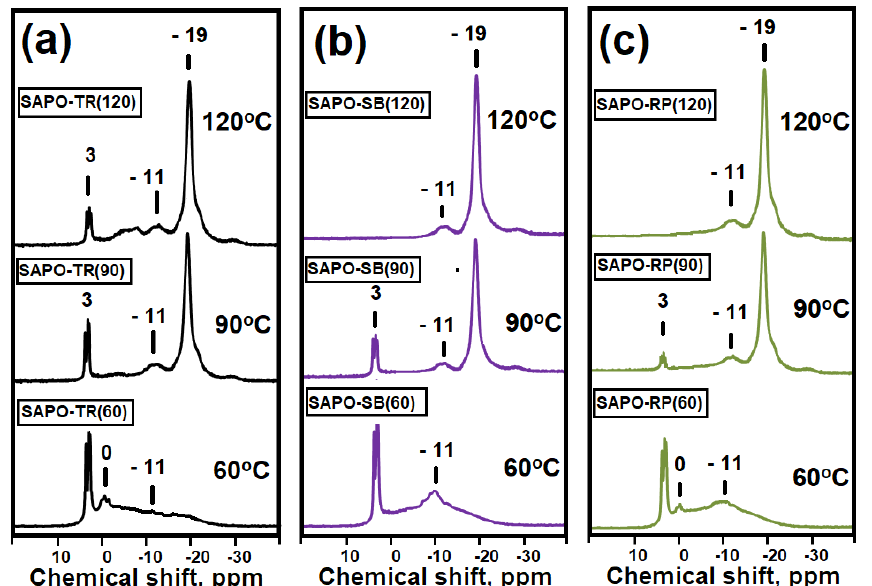
Figure 8. MAS NMR 31 P spectra of initial silicoaluminophosphate gels prepared using various boehmites and aged at 60–120 °C: ( a ) Samples of gels prepared using TR boehmite; ( b ) Gel samples prepared using boehmite SB; ( c ) Gel samples prepared using boehmite RP.